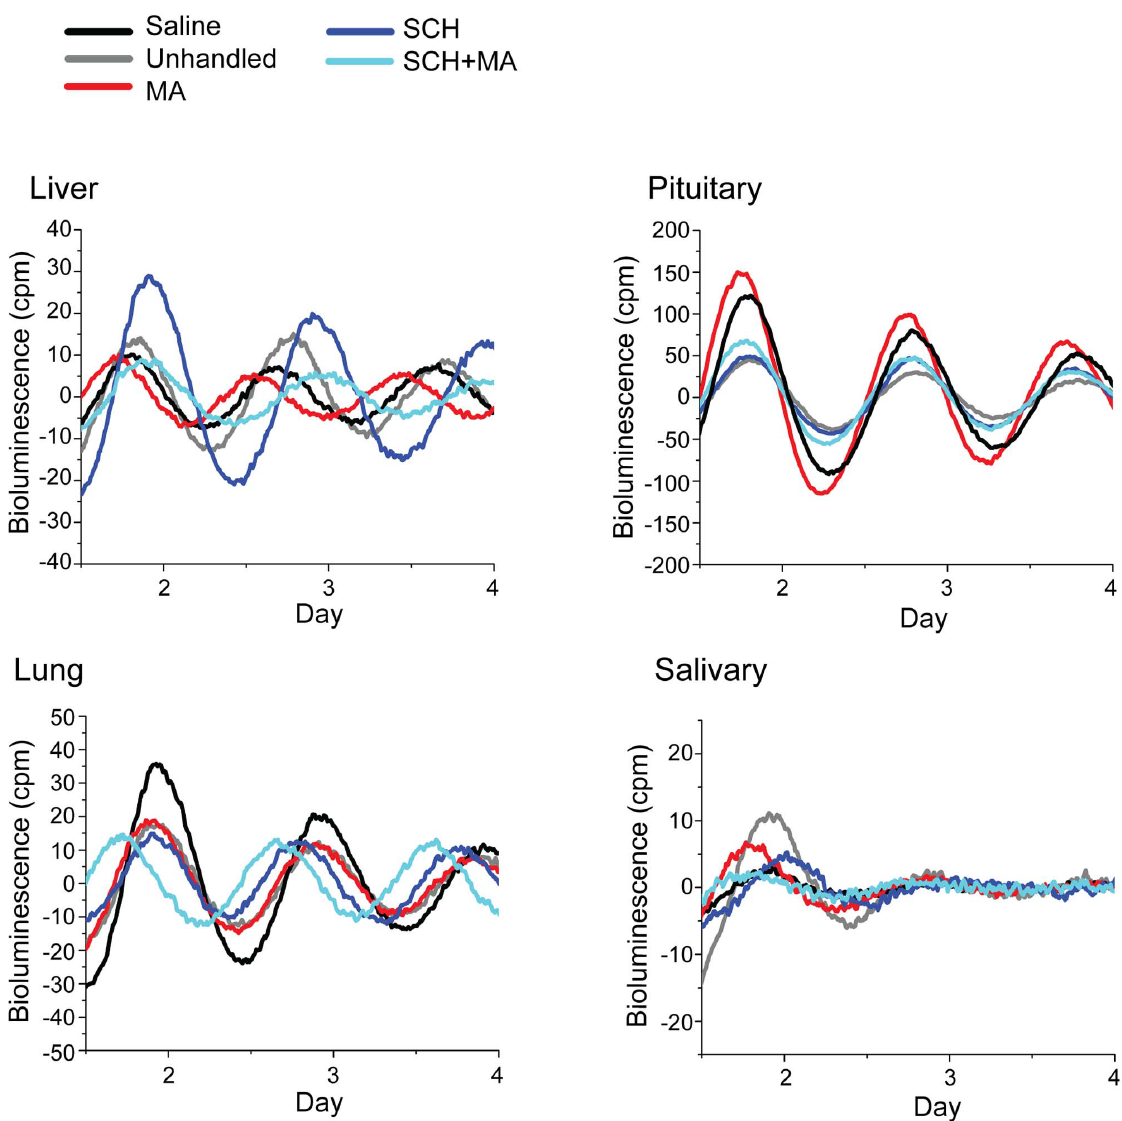
Figure 5. Representative PER2::LUC traces from liver, lung, pituitary, and salivary gland. Traces depict baseline subtracted, detrended bioluminescence (PER2::LUC) from mice in the saline-injected (black), unhandled (gray), MA-injected (red), SCH-injected (blue), and SCH-pretreated (SCH + MA, aqua) conditions.